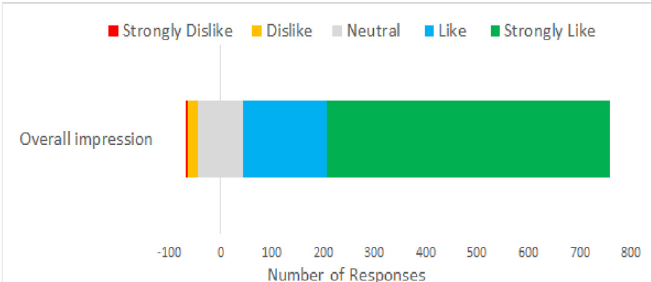
Figure 3. Overall patient impression of drive-through systems for medical